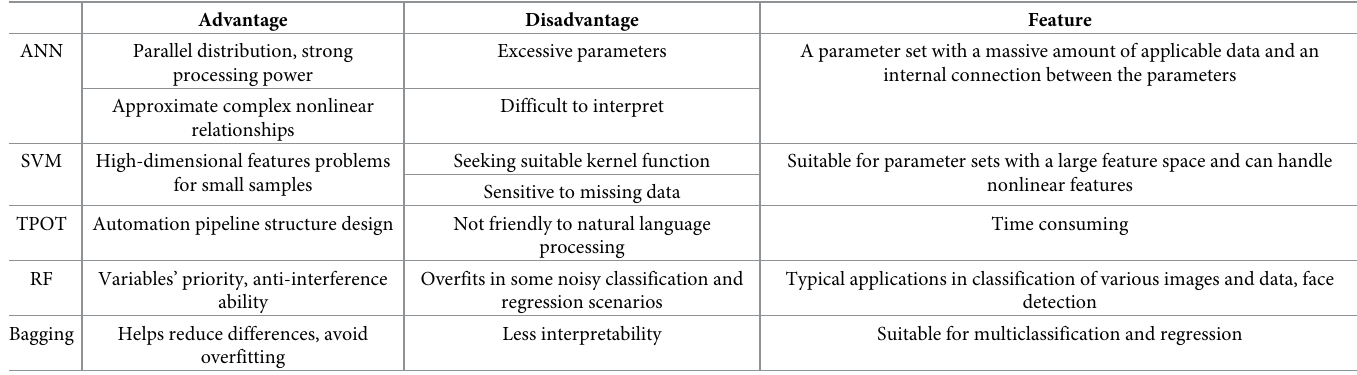
Table 1. Comparison of automl